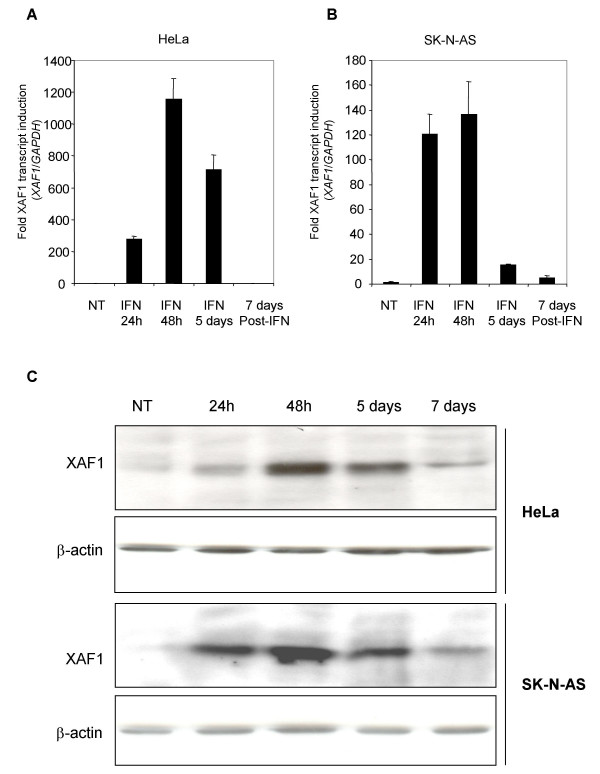
Effect of IFN-β exposure on xaf1 expression at the transcript and protein levels. HeLa (A) and SK-N-AS (B) cells treated with 500 U/mL IFN-β for 0 hour, 24 hours, 48 hours or 5 days, or after a 7-day IFN-β free period were harvested, total RNA was extracted and subjected to quantitative RT-PCR and indexed to GAPDH transcript levels. (C) 30 μg of total protein extract were resolved by 12% SDS-PAGE and XAF1 was detected using an anti-XAF1 mouse monoclonal antibody. Loading was checked by using an anti-β-actin monoclonal antibody.